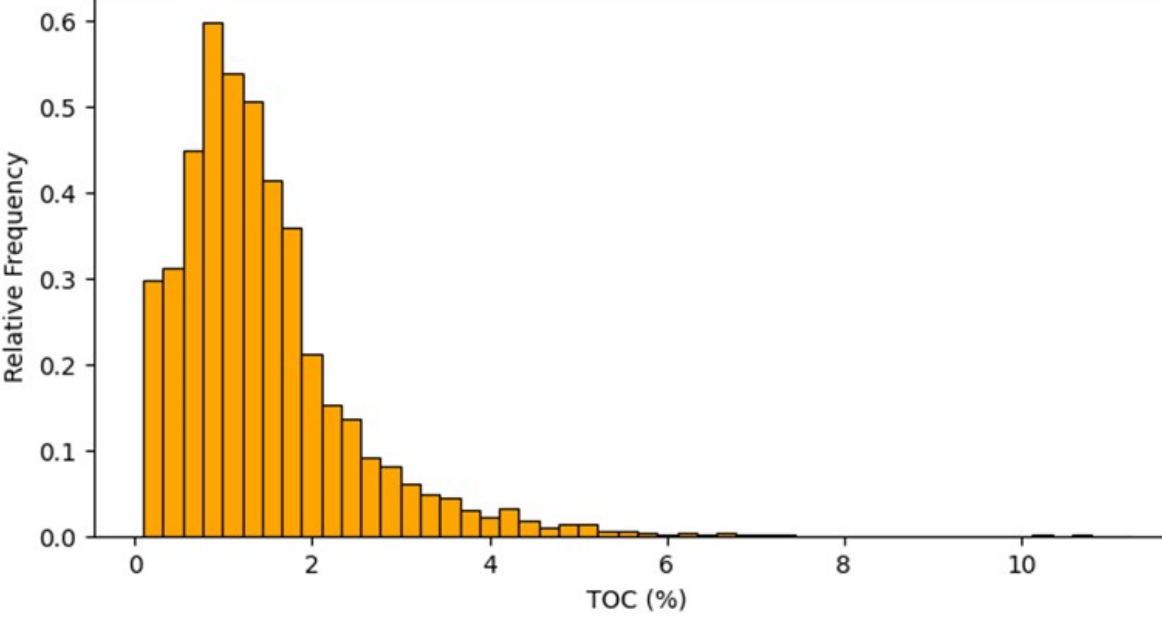
Figure 8. Total organic carbon (TOC) content histogram for the Montney Formation. This distribution is based on 10,000 Rock Eval analyses that were within the public domain. See the main text for details.